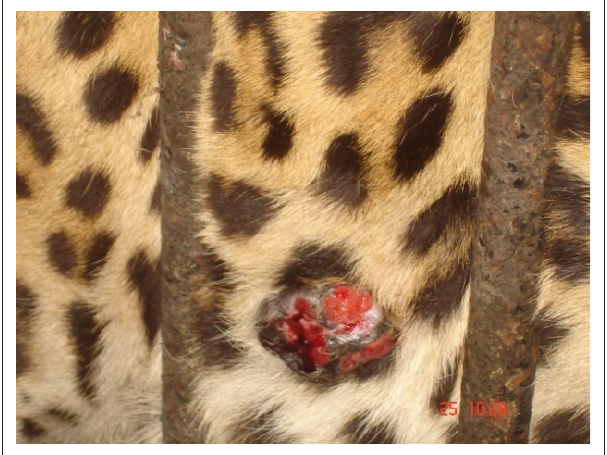
FIGURE 1: Cutaneous growth on right lateral flank with non-healing type of wound.